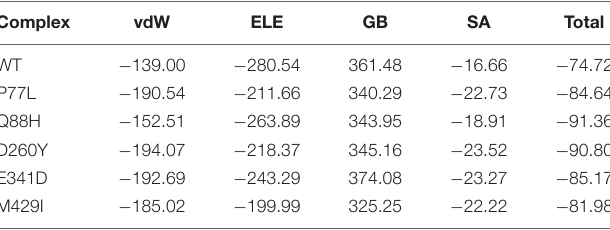
TABLE 1 | MM/GBSA analysis of the wild-type (WT) and mutant complexes.